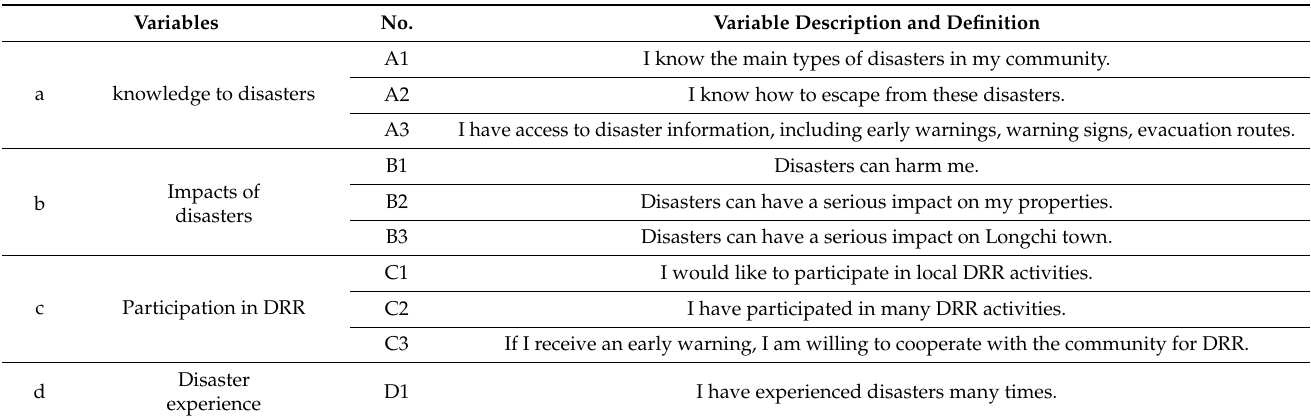
Table 2. Index for measuring public risk